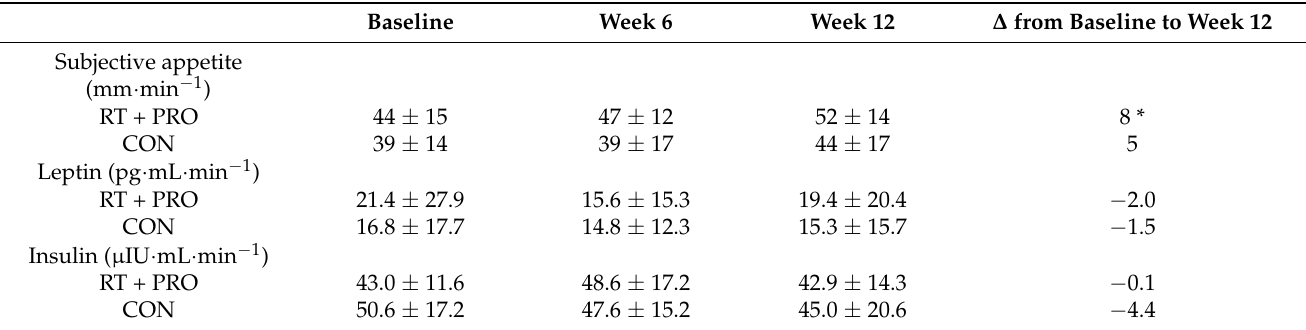
Table 4. AUC (150 min) for subjective appetite sensations and circulating hormones concentrations at baseline, Week 6 and Week 12 during the meal tolerance test in RT + PRO and